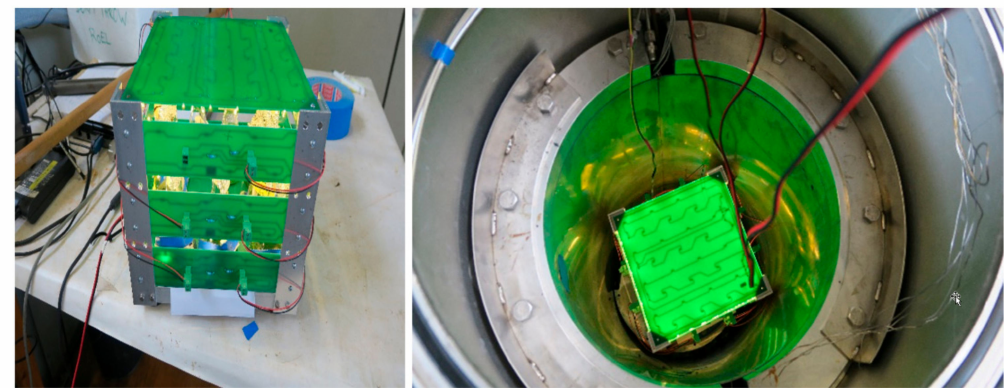
Figure 1. LED light tower assembled from panels connected in parallel, with culture flasks receiving continuous white light ( left ) and its positioning inside the GEUSE II vessel for exposure of Limnospira indica PCC 8005-P2 and -P6 cultures to spent nuclear fuel (SNF) gamma rays ( right